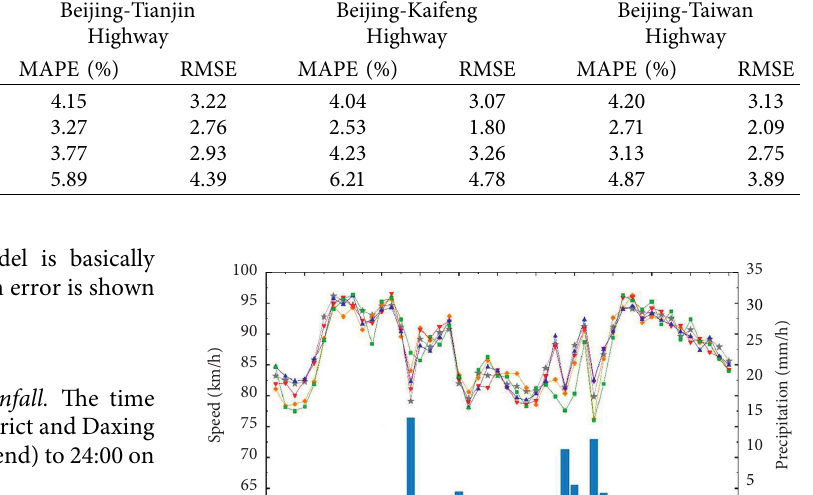
Table 5: Errors in traffic flow speed prediction during unsustained rainfall. Model